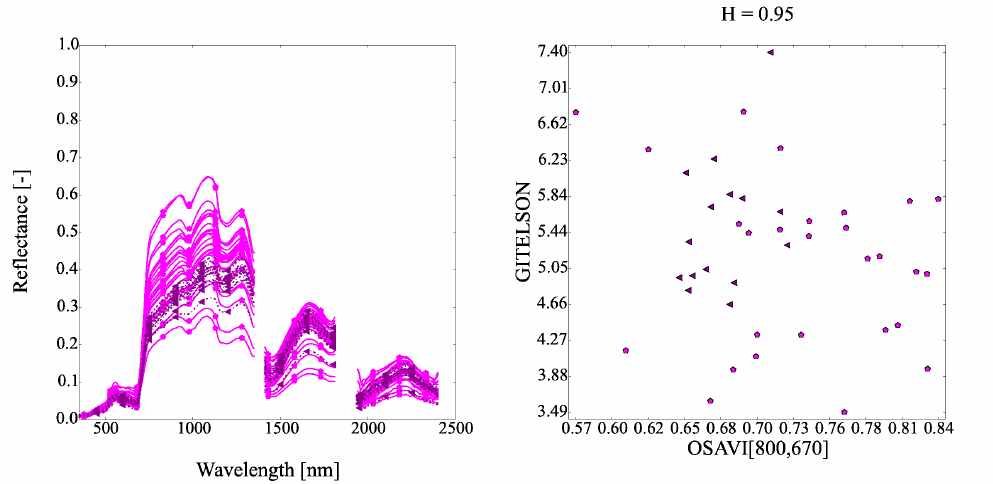
Figure 13. ( Left ) spectral signatures of CA_HV (pink) and PI_CV (magenta); ( Right ) map of Optimised Soil-Adjust Vegetation Index (OSAVI) [800,670] and GITELSON values for each vegetation type, H is the Hellinger distance